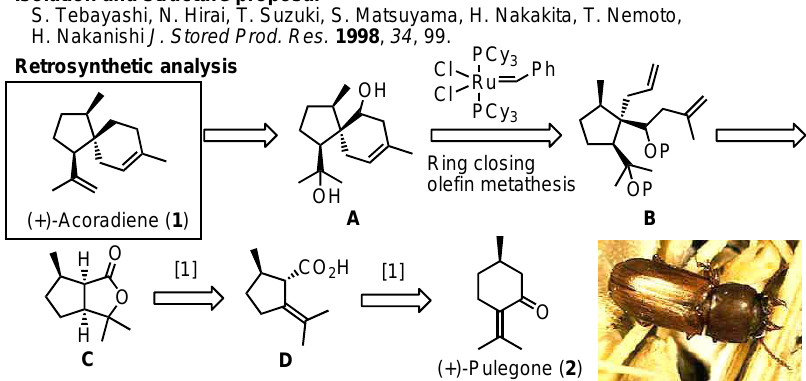
(+)-Acoradiene, Aggregation Pheromone of the Broad-horned Flour Beetle, Gnatocerus cornutus Isolation and structure proposal S. Tebayashi, N. Hirai, T. Suzuki, S. Matsuyama, H. Nakakita, T.